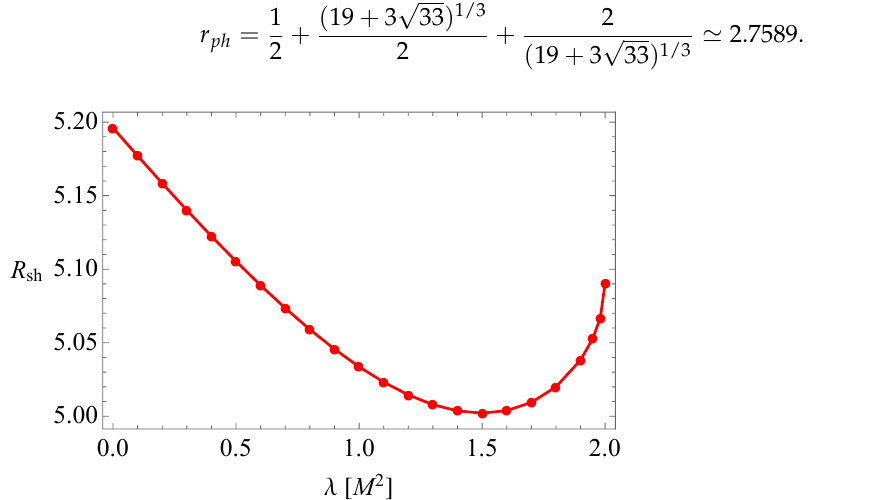
Figure 8. Black hole shadow radius as a function of the parameter λ . We set the black hole mass to M =